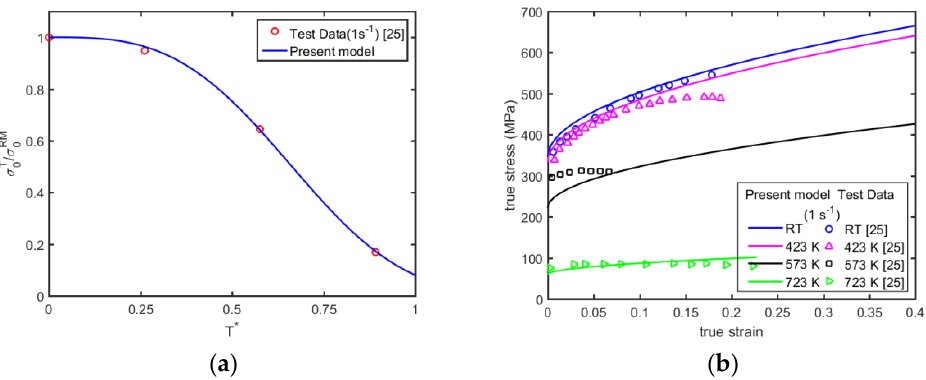
Figure 8. Comparison of the present model predictions with the tensile test data for 2024-T351 aluminum alloy. ( a ) σ 0 T / σ 0 Ta versus T * at a plastic strain of 0.075 under strain rate of 1 s − 1 ; and ( b ) true stress-true strain curves at elevated temperatures.